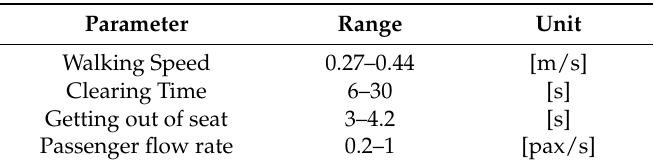
Table 1. Basic parameters ranges [22].